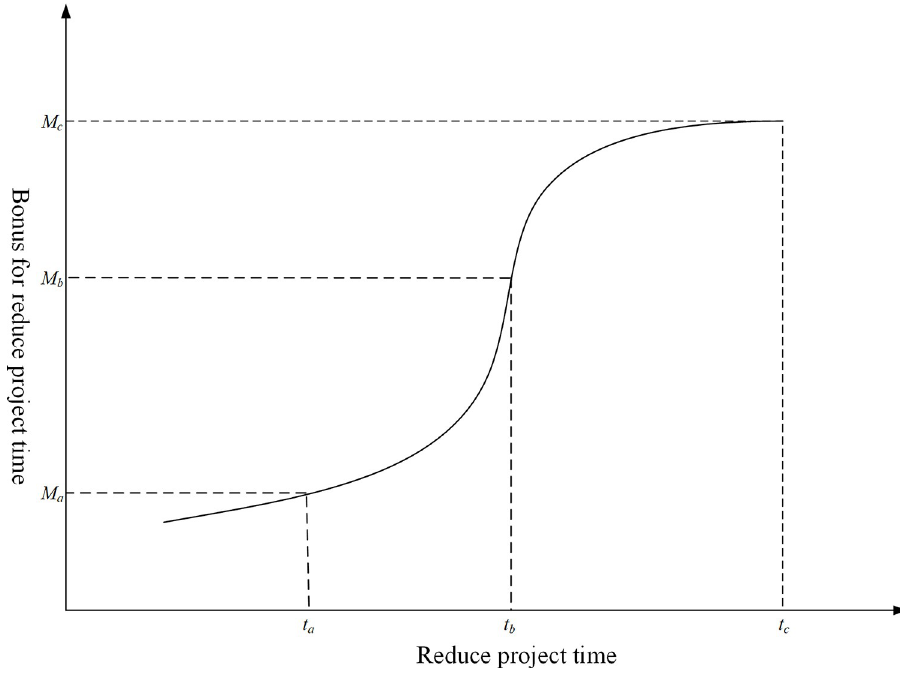
Fig 4. Bonus of duration reduction